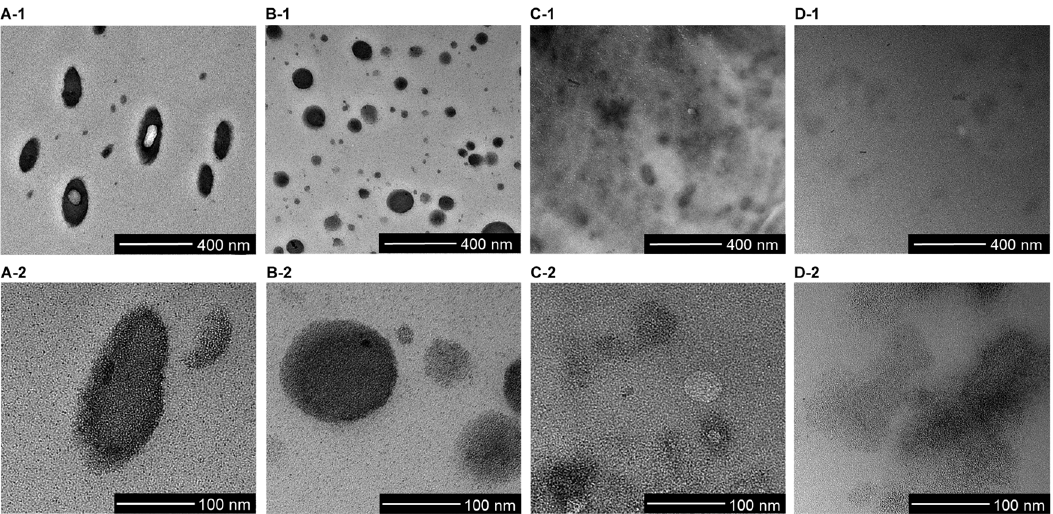
Figure 4. TEM images showing the morphological structures of the ( A-1 , A-2 ) PR5, ( B-1 , B-2 ) PR10, ( C-1 , C-2 ) PSR5, and ( D-1 , D-2 ) PSR10 blends. The dark areas are PR phases stained with RuO 4 .